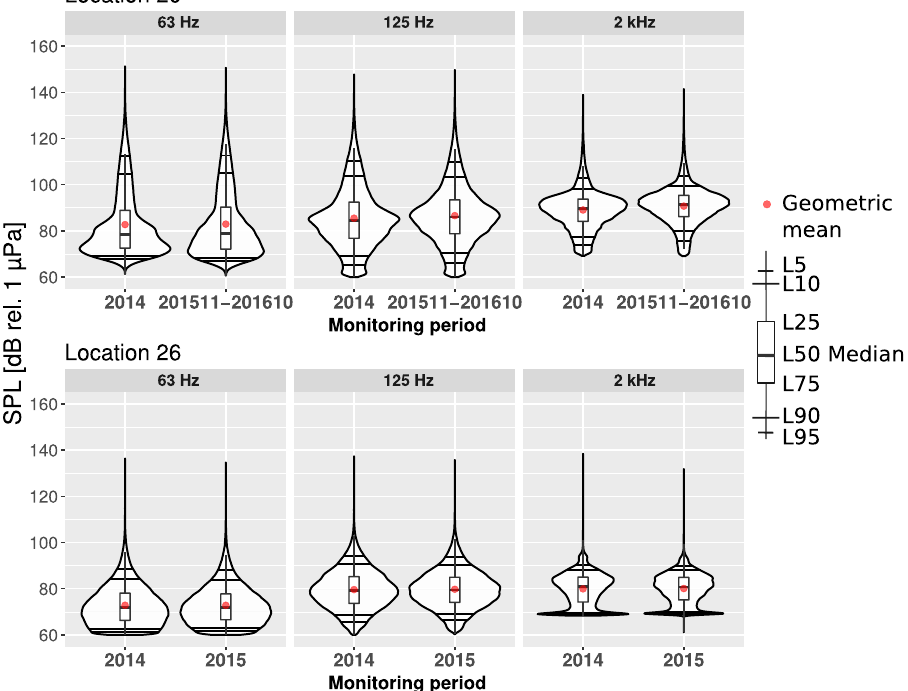
Figure 8. Estimated probability density functions of the measured SPL at three different one-third octave bands for the measurement location 20 (Tallinn, EST) and location 26 (Puck Bay, POL) for two monitoring periods.